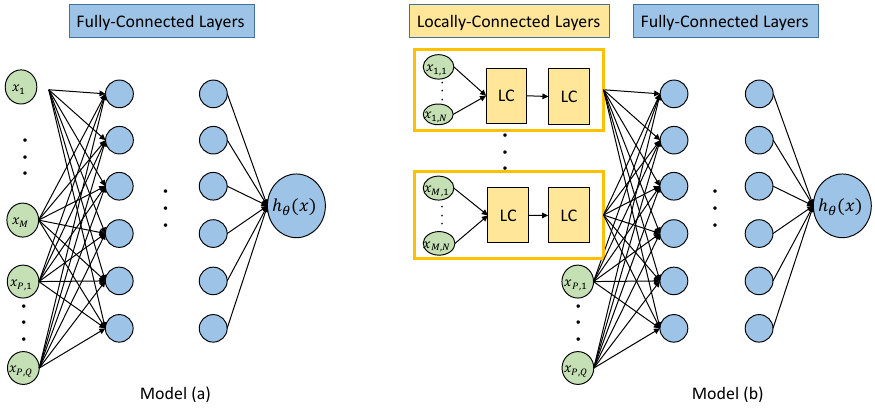
Figure 5. ANN structure for model (a) and model